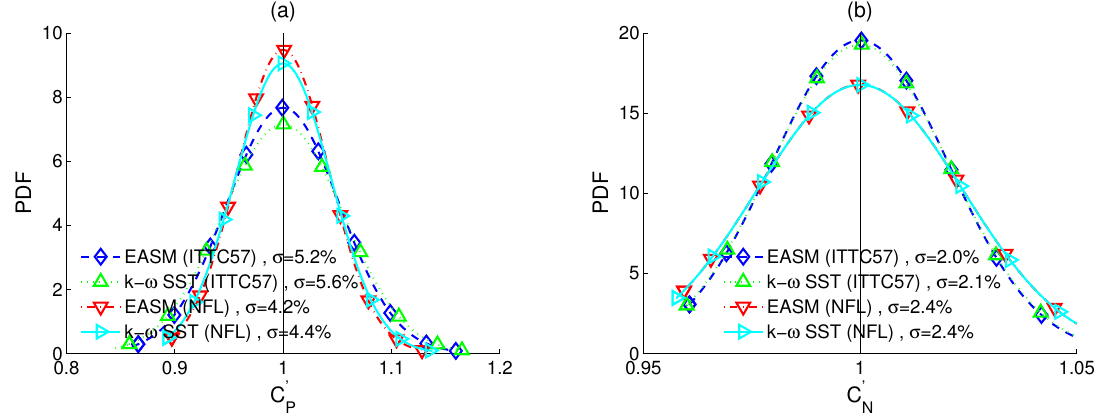
Figure 15. The probability density functions (PDFs) of the normalized correlation factors using the CFD based form factors with the ITTC-57 and the numerical friction lines. ( a ) C (cid:48)